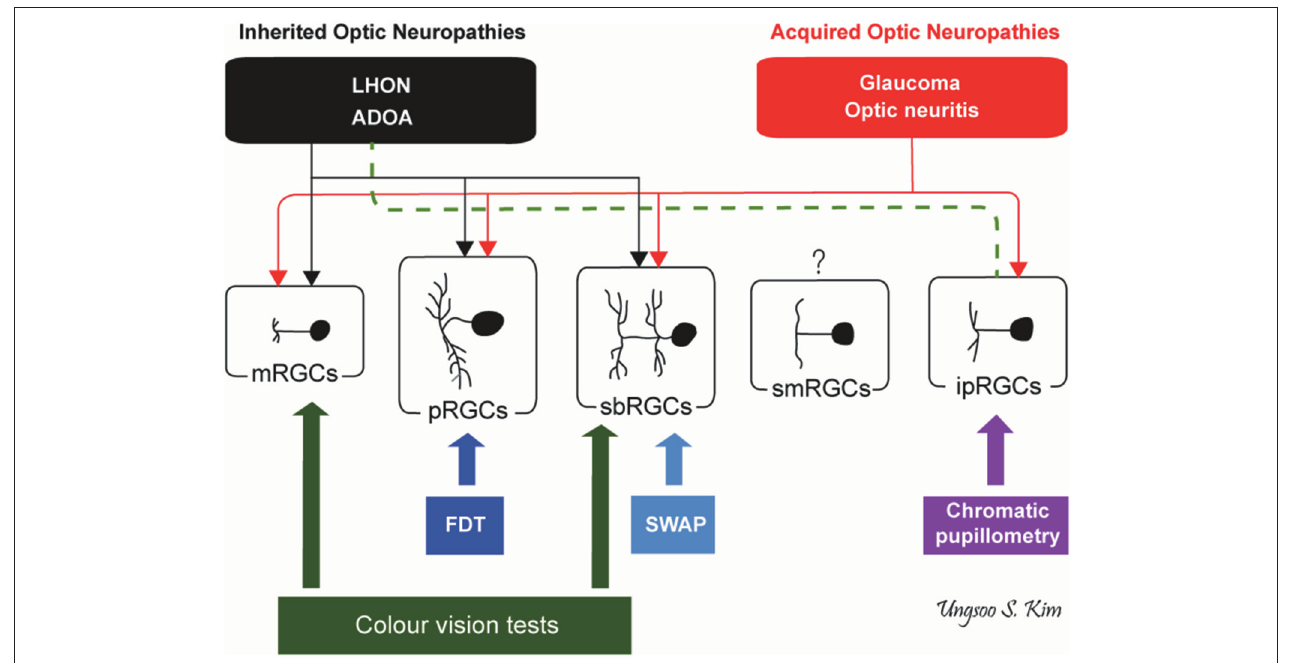
FIGURE 5 | Pattern of RGC involvement in optic neuropathies. The types of RGCs affected in inherited optic neuropathies and acquired optic neuropathies are indicated by black and red lines, respectively. The dotted green line indicates the preservation of ipRGCs in inherited optic neuropathies. ADOA, autosomal dominant optic atrophy; FDT, frequency doubling technology; ipRGCs, intrinsically photosensitive retinal ganglion cells; LHON, Leber hereditary optic neuropathy; mRGCs, midget retinal ganglion cells; pRGCs, parasol retinal ganglion cells; sbRGCs, small bistratified retinal ganglion cells; smRGCs, smooth monostratified RGCs; SWAP, short wavelength automated perimetry ( by Ungsoo S. Kim